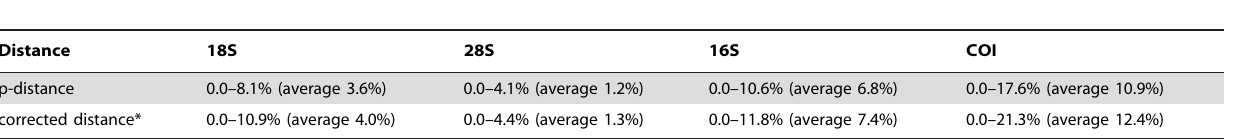
Table 3. Ranges of genetic divergence for the 18S, 28S, 16S and COI gene fragments between all Cyclophorus species included in this analysis (excluding